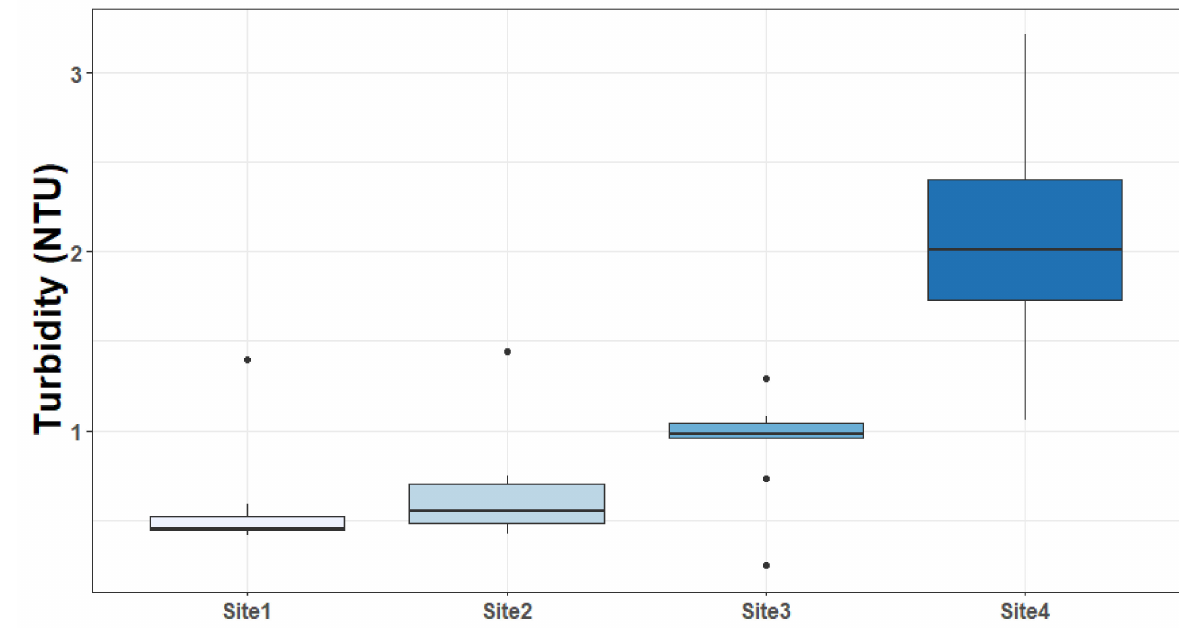
Figure 6. Boxplot for turbidity test results for the four sites.